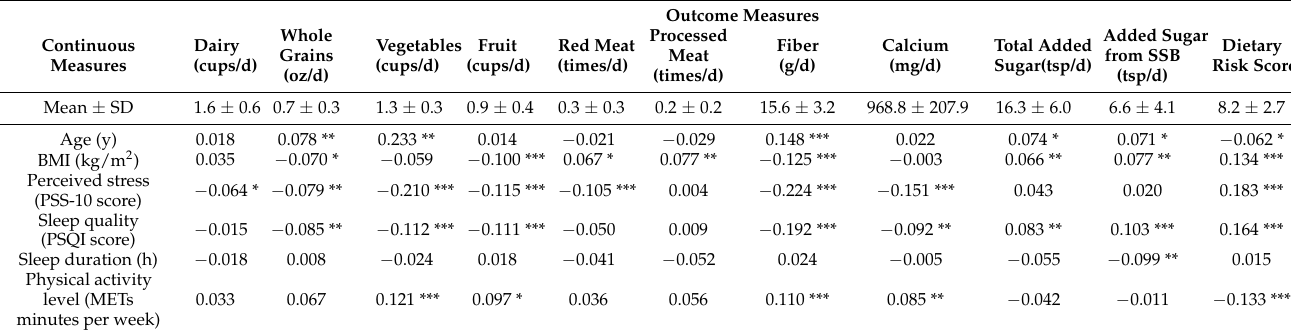
Table 3. Dietary intake, dietary risk score, and their associations with demographic and health characteristics of U.S. higher education students (continuous variables).